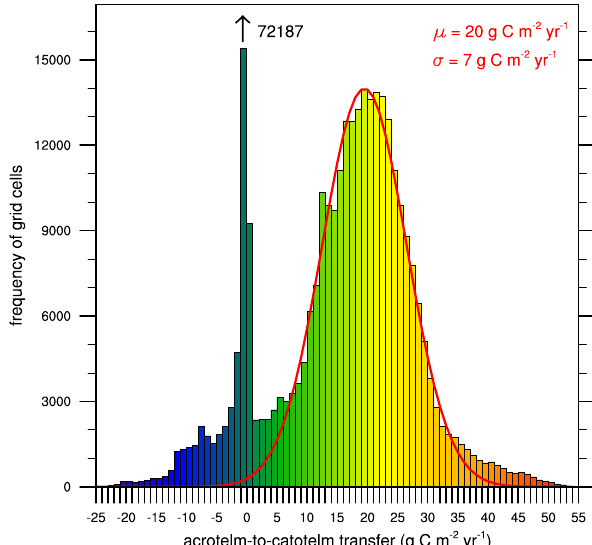
Fig. 7. Frequency histogram of acrotelm-to-catotelm transfer rates (10yr averages) from simulated grid cells in LPX over the Holocene (last 10kyr and for bins with a width of 1gCm − 2 yr − 1 ). Negative values on the x-axis denote a transfer of carbon from the catotelm to acrotelm, implying C loss. Rates below zero ( − 1 < 0gCm − 2 yr − 1 ) occur most frequent and are outside the frequency scale as indi- cated. A normal distribution ( µ , σ ) is shown as an approximative distribution of positive rates (red